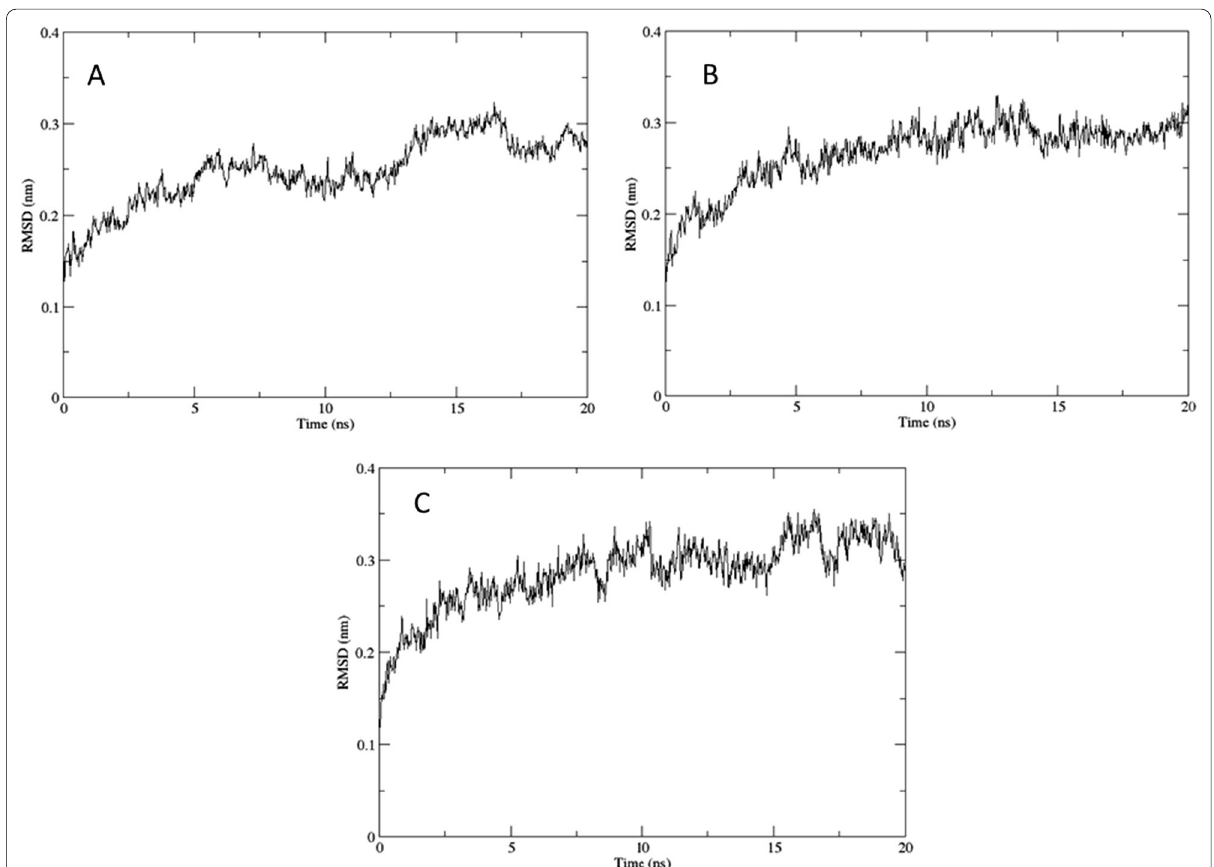
Fig. 11 RMSD curves showing instantaneous deviation of structures of: A isorhamnetin–XOD, B kaempferol–XOD and C quercetin–XOD complexes from their respective initial structures over a 20-ns simulation time